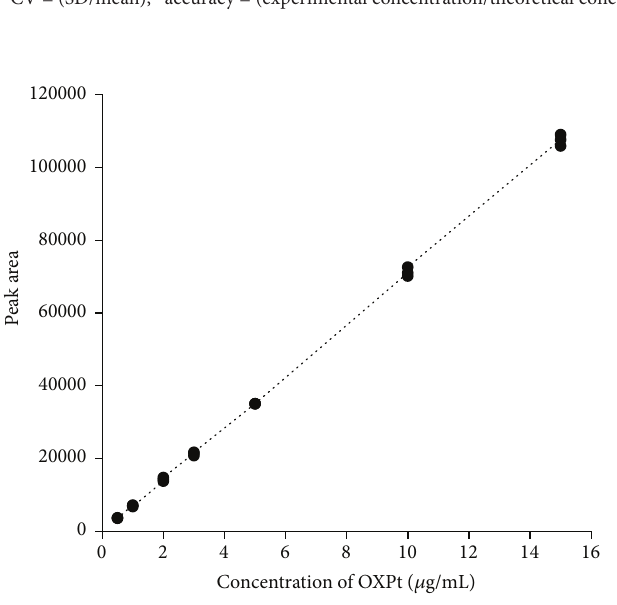
Figure 5: Calibration plot of peak area against concentration of OXPt ( 𝑦 = 7159.7𝑥 − 140.9 ; 𝑟 = 0.9998 ; 𝑛 = 3